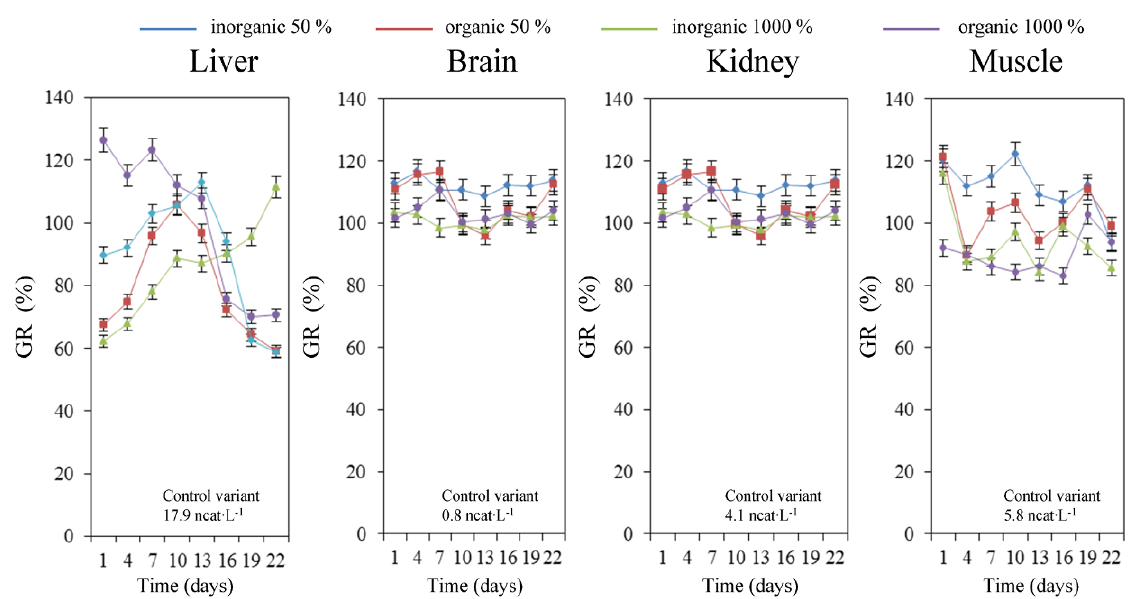
Figure 5. GR activity in the examined organs. The level was related to the controls. Error bars indicate standard error of mean for three specimens. GR was determined by spectrometric assay. The GR activity results were related to a control group and recalculated as a percentage of control. Control group was determined as a one hundred percent from individual values as follows: 17.9 ncat L -1 , brain 0.8 ncat L -1 , kidney 4.1 ncat L -1 and muscle 5.8 ncat L -1 .